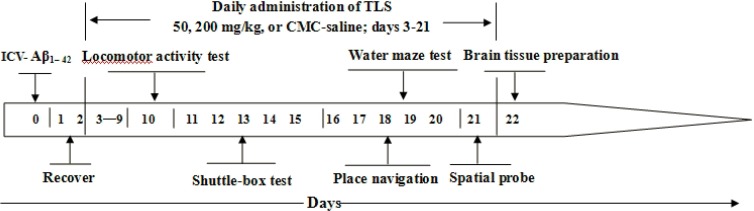
Experiment schedule.